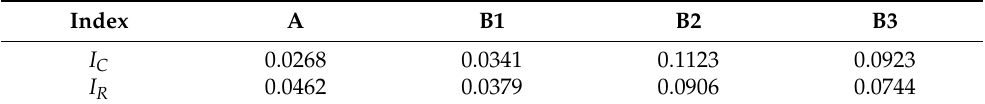
Table 3. Consistency check calculation results.